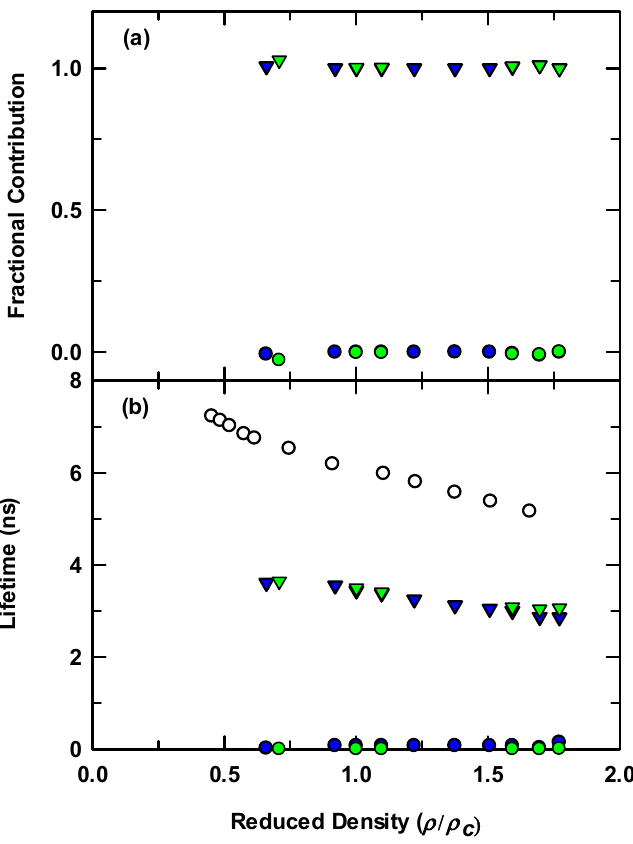
Figure 8. Decay parameters at 323 K for C153 / [P 6,6,6,14 ] + [Tf 2 N] − / scCO 2 (blue and green filled symbols). Open circles in the lower panel are from the C153 fits in scCO 2 at 323 K. All IL data were acquired using excitation at 24,691 cm − 1 , with emission at 22,222 cm − 1 (blue symbols) and emission at 19,608 cm − 1 (green symbols). Uncertainty is contained within the symbol size.